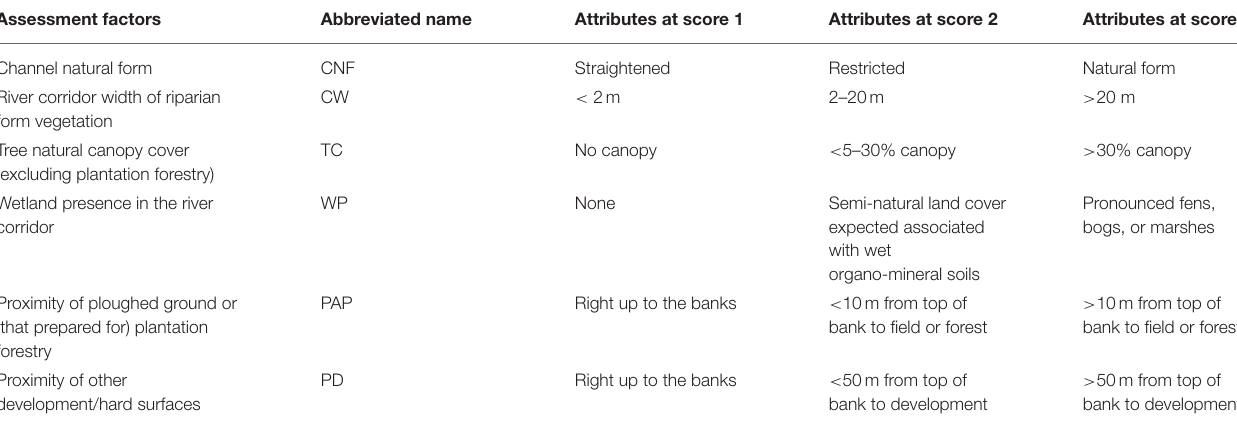
TABLE 4 | Visual scoring assessment metrics used on 10 randomly located points and associated 100m reaches